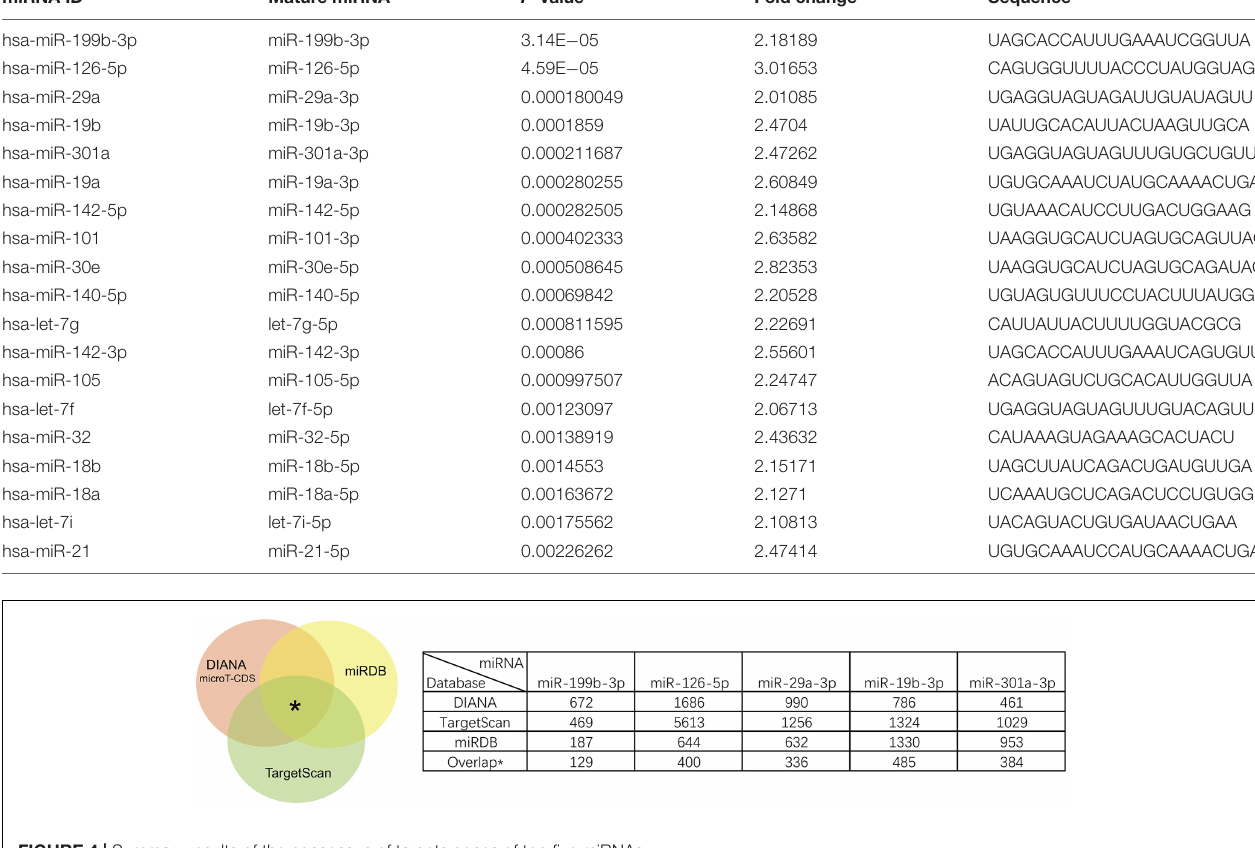
TABLE 3 | The DE miRNAs.